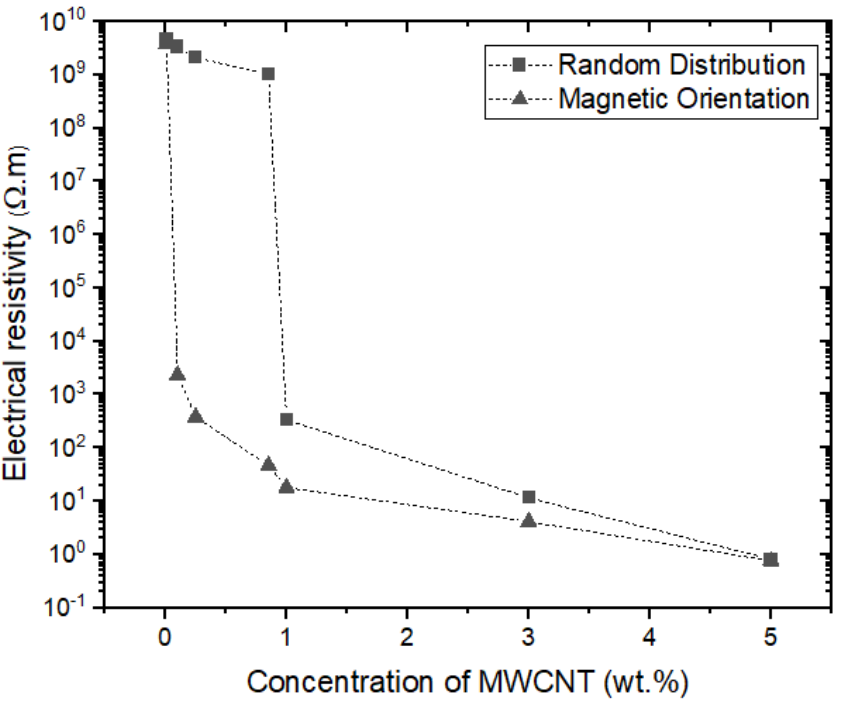
Figure 6. Electrical resistivity of MWCNT/PDMS nanocomposites prepared with and without magnetic alignment.